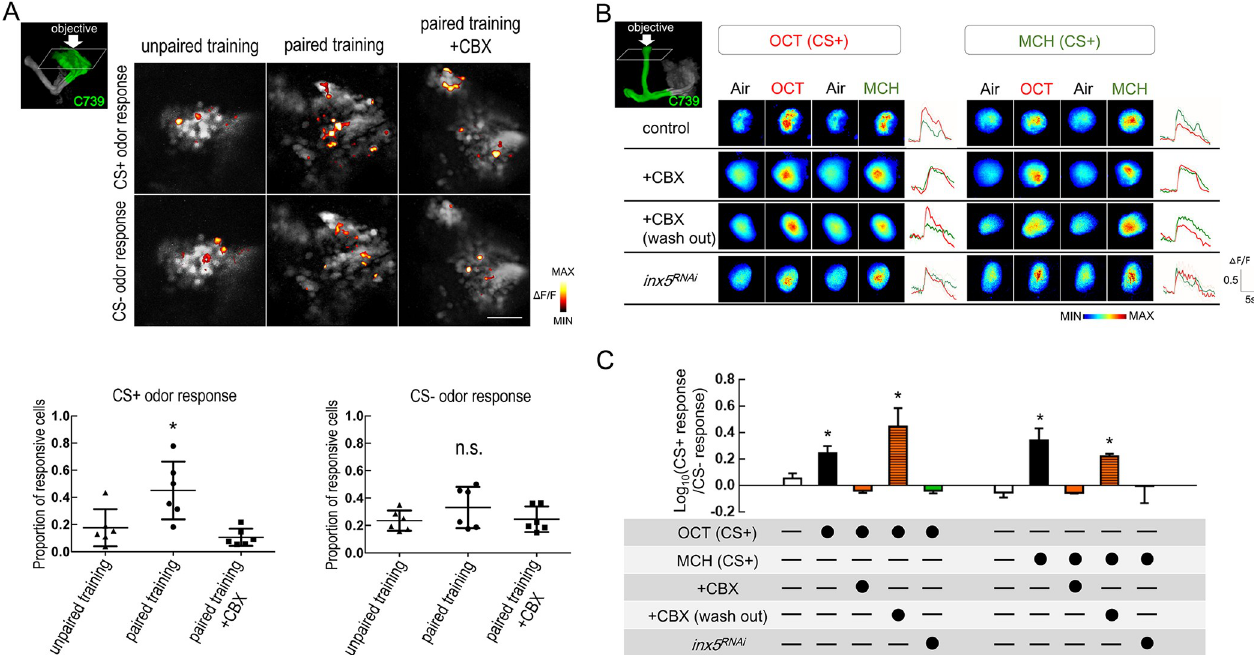
Fig 6. Knockdown of INX5 in αβ neurons disrupts 3-hour ARM-specific memory trace. (A) Top diagram illustrating the paired and unpaired training protocols. The GCaMP6 response at 3-hour after training was assayed after exposure to a 2-min cold shock given at 2-hour after training by placing a plastic vial containing the trained flies in ice water. For the paired training group: flies received CS+ odor with electrical shocks, followed by exposure to the CS- odor without electrical shock. CS- odor was applied after a 1-min exposure to fresh air. For the unpaired training group: flies received CS+ odor without electrical shock, followed by exposure to the CS- odor without electrical shock, and the electrical shocks were applied 1-min later after CS- odor. Odor/shock paired training induced an increase in the proportion of odor responsive αβ neurons to the conditioned (CS+) odor, but not the unconditioned (CS-) odor 3 hours after training, compared to the unpaired training group. The proportion of odor responsive αβ neurons to the CS+ odor was reduced after treatment with the gap junction blocker CBX (MCH as CS+ odor; OCT as CS- odor). � , p < 0.05; one-way analysis of variance followed by Tukey’s test. Genotype: C739-GAL4/ UAS-GCaMP6m; +/+ . (B) Odor/shock paired training (control group) induced an increase in the GCaMP6 responses in the α -lobe axonal branch of the MB neurons to the training odor [OCT-trained flies: OCT (CS+), MCH-trained flies: MCH (CS+)], and this increase was abolished with CBX treatment (row 2, +CBX) or C739-GAL4 > UAS-inx5 RNAi (v6950) flies (row 4, inx5 RNAi group). The GCaMP6 responses were recorded 3 hours after training with a 2-min cold shock given at 2-hour postconditioning. (C) Quantification of the enhanced GCaMP6 responses to the training odor (CS+) relative to the non-training odor (CS-) in the α -lobe in OCT-trained (left panel) or MCH-trained (right panel) flies. The recordings were performed in the α -lobe tips. The Log ratios of the CS + response to the CS- response were calculated using the peak response amplitudes. Each value represents the mean ± SEM (n = 8–10). � , p < 0.05; one-way analysis of variance followed by Tukey’s test. Genotypes: (1) C739-GAL4/UAS-GCaMP6m; +/+ , (2) C739-GAL4/UAS-GCaMP6m; UAS-inx5 RNAi (v6950)/+ .